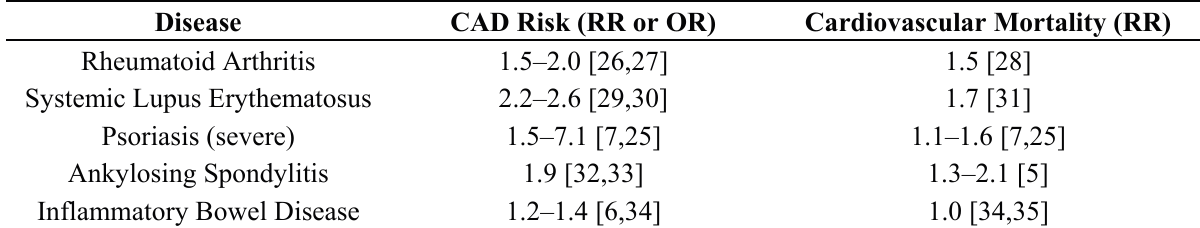
Table 1. Relative risk of cardiovascular morbidity and